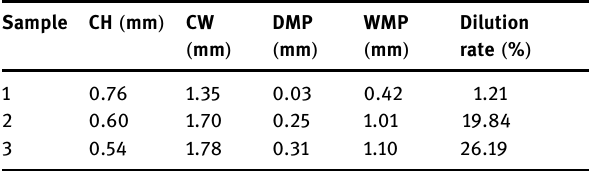
Table 4: Cross - sectional dimensions of coatings and molten pool for each sample Sample CH ( mm ) CW (